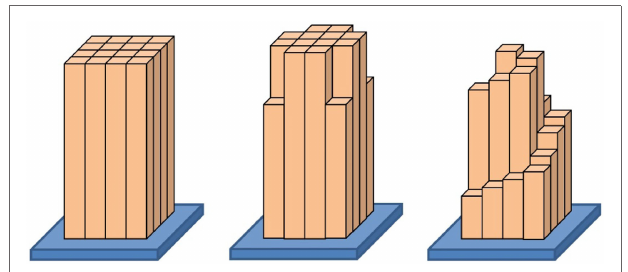
FIGURE 1 | Rigid model with geometric